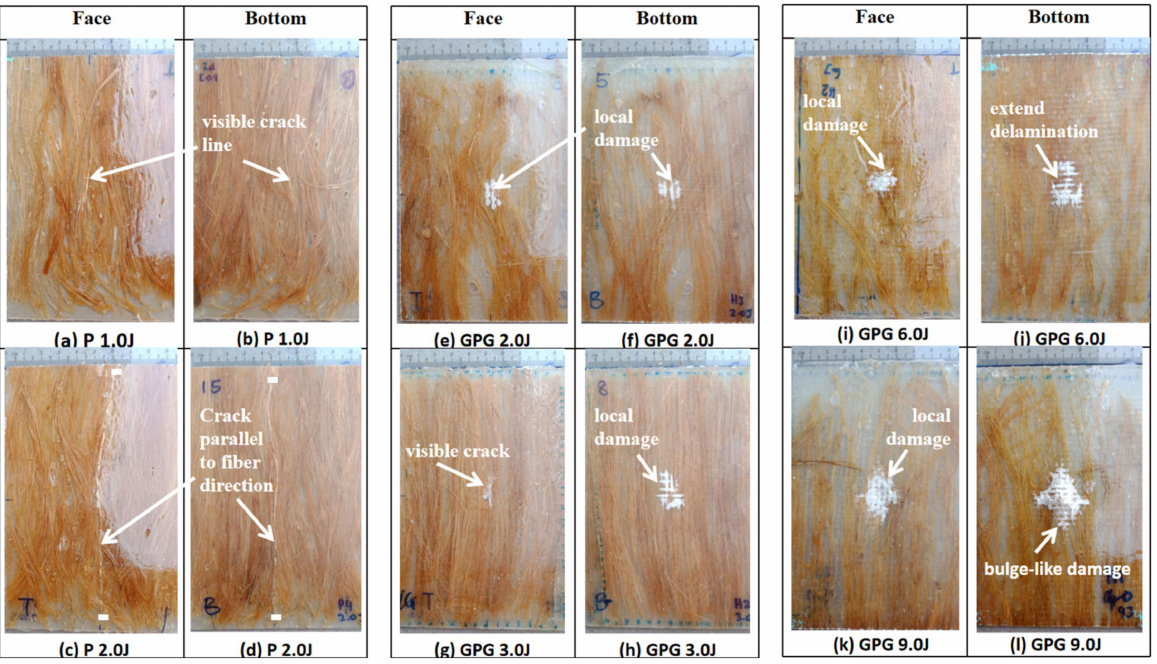
Figure 15. Visual damage of impacted P and